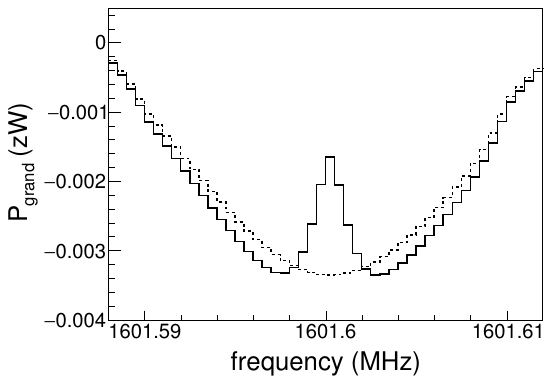
Figure 9 . Differences between P 5-parameter fit and P perfect fit , where the former was obtained with grand grand 5-parameter fit and the latter with perfect fit. The dashed line was obtained without ξ Step-1 . 5 and ξ Step-3 , while the solid line reflects the two frequency-independent scale factors.